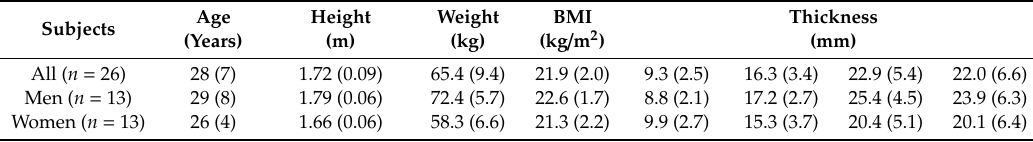
Table 1. Demographic and ultrasound data of the total